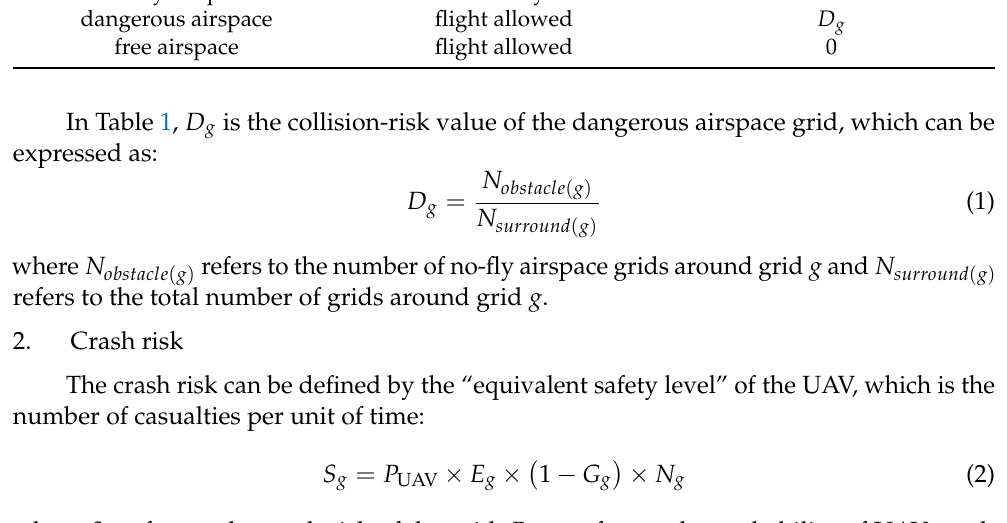
Table 1. Grid collision risk. Grid Category Flight Criteria No-fly airspace dangerous airspace free